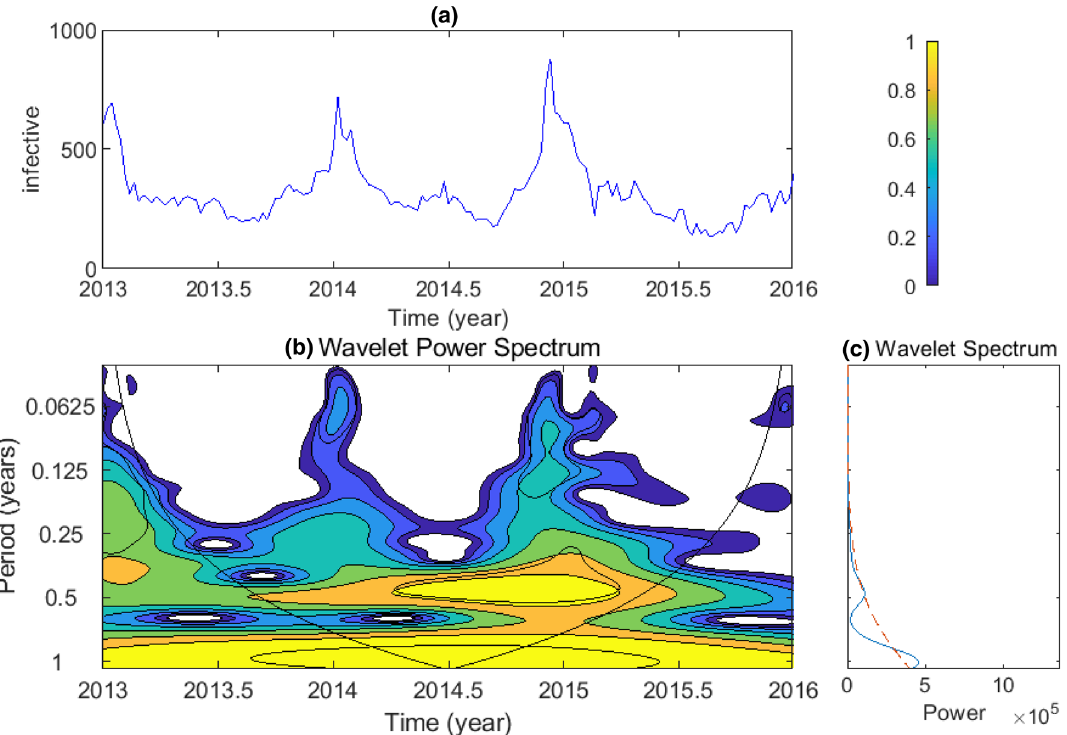
Figure 1. Temporal periodicity analysis of influenza in Taiyuan using the wavelet method. ( a ) Weekly infective number of influenza from 2013 to 2016 of Taiyuan sentinel hospitals. ( b ) The wavelet spectrum analysis corresponds to time series of the data of ( a ). High power values are colored in yellow, orange and cyan denote intermediate power, blue denotes low one. Note the black line is the 95% confidence level. Only patterns within these lines which can neglect the edge effects are considered reliable. ( c ) The average wavelet spectrum (blue line) and the corresponding 95% confidence